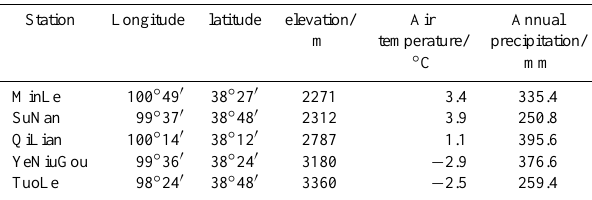
Fig. 1. Locations of weather stations, hydrological stations, and DEM of the upper basin of Heihe River.